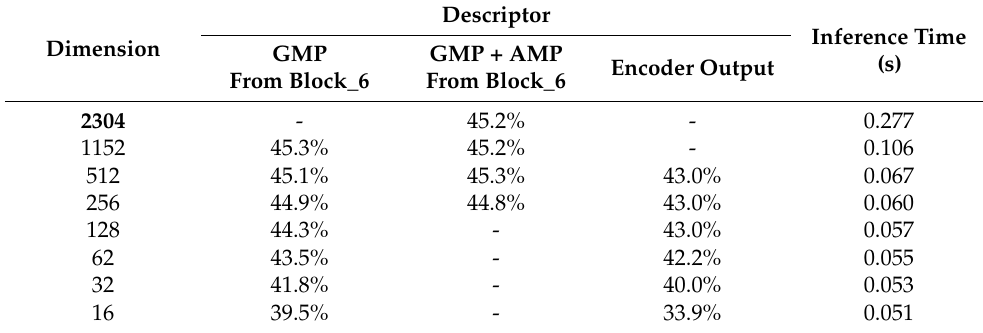
Table 3. Effect of channel expansion on the Flowers dataset (mAP for top 5). GMP = global max